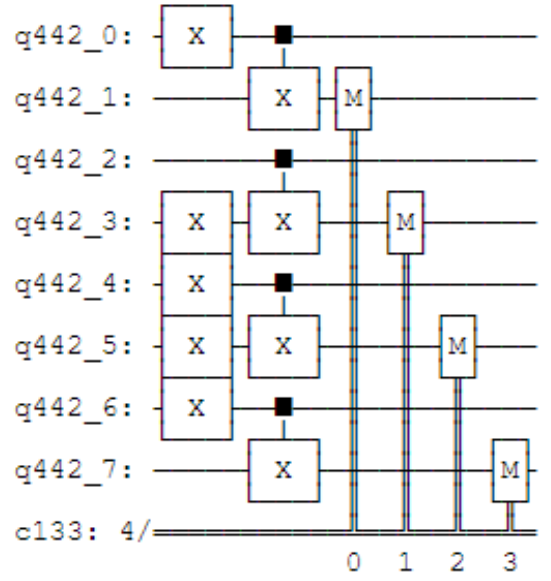
Figure 16. Classical XOR gate using the CNOT gate.